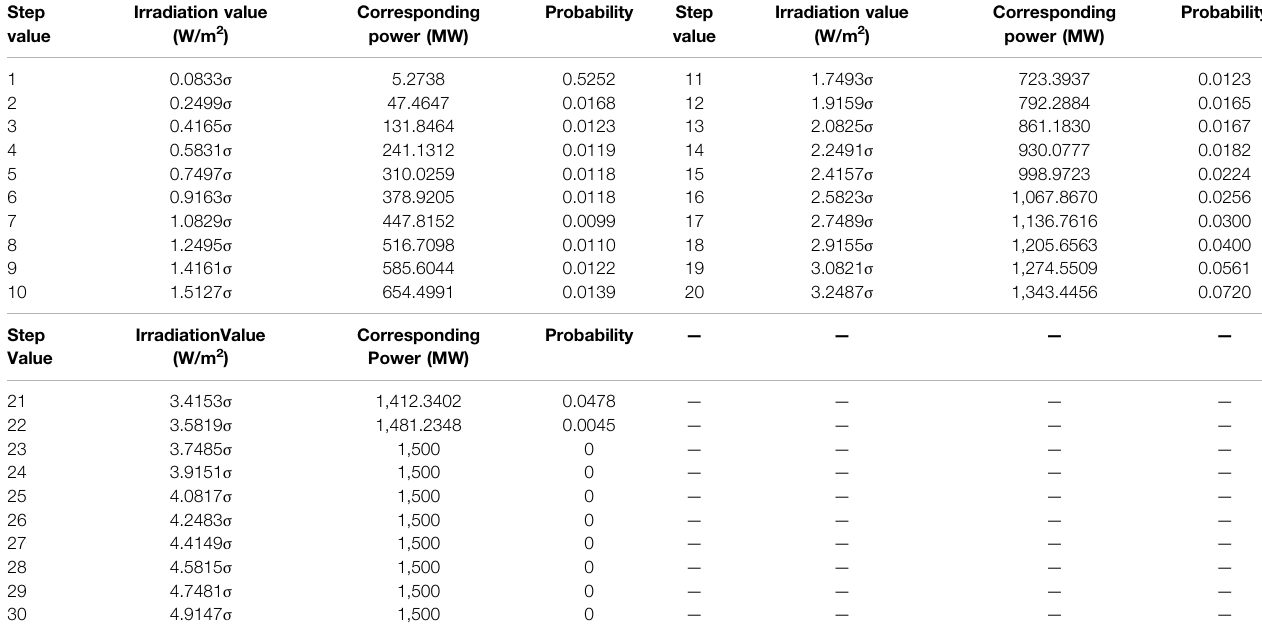
Corresponding Probability Step Irradiation value Corresponding power (MW) value (W/m 2 ) power